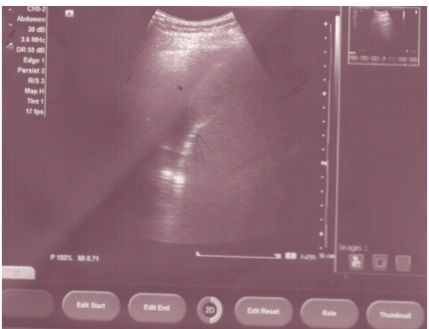
Figure 3: Thoracic ultrasound shows effusion in the right pleural